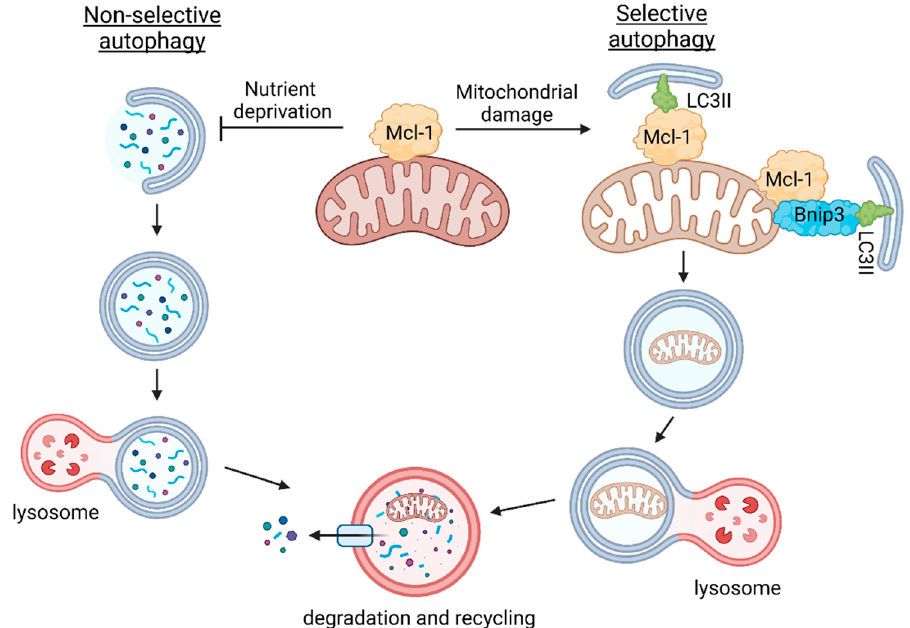
Figure 7. Opposing effects of Mcl-1 on nonselective autophagy and selective mitochondrial autophagy (mitophagy). Mcl-1 at the mitochondria suppresses formation of autophagosomes during nutrient deprivation possibly to protect healthy mitochondria from degradation. In contrast, Mcl-1 promotes autophagy of dysfunctional mitochondria by functioning as a mitophagy receptor or by coordinating with Bnip3. Created with BioRender.com (accessed on 21 March